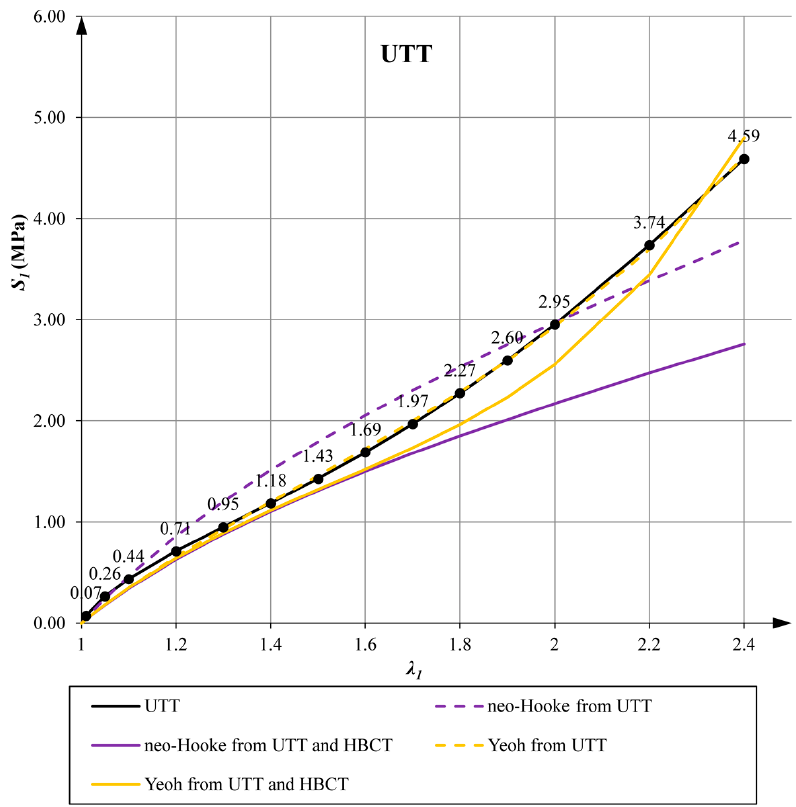
Figure 8. Comparative stress ‐ elongation plot during UTT.